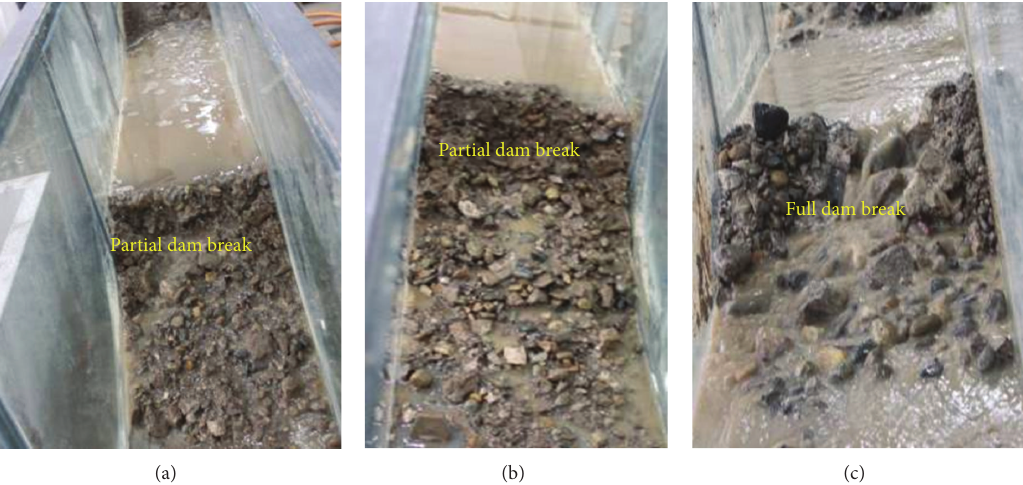
Figure 7: Final patterns of dam break influenced by the water flow conditions: (a) water flow is 0.1L/s; (b) water flow is 0.2 L/s, and (c) water flow is 2.0L/s.